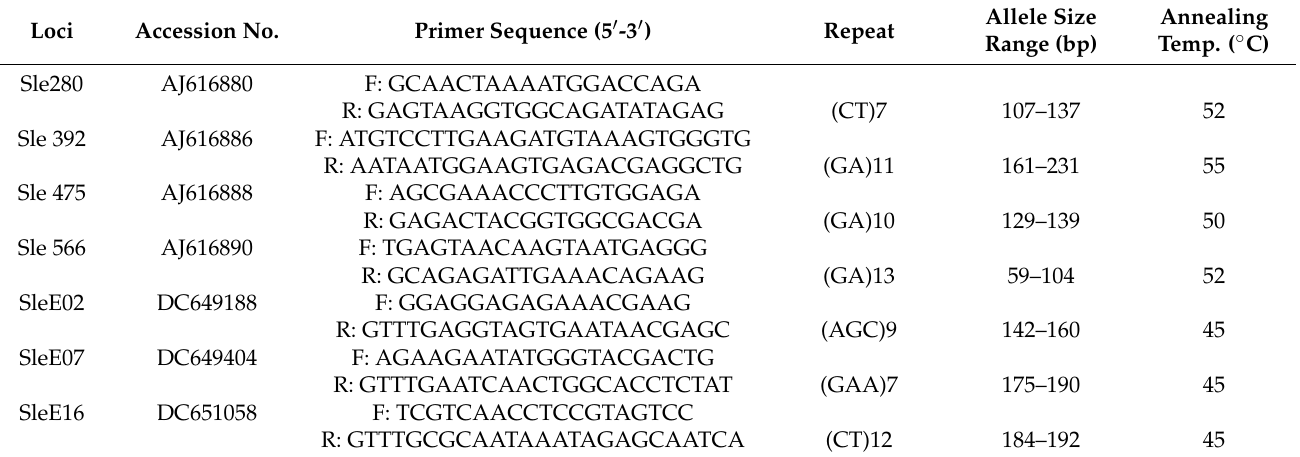
Table 1. Characteristics of four SSR loci and three EST-SSR loci developed from Shorea leprosula . Loci Accession